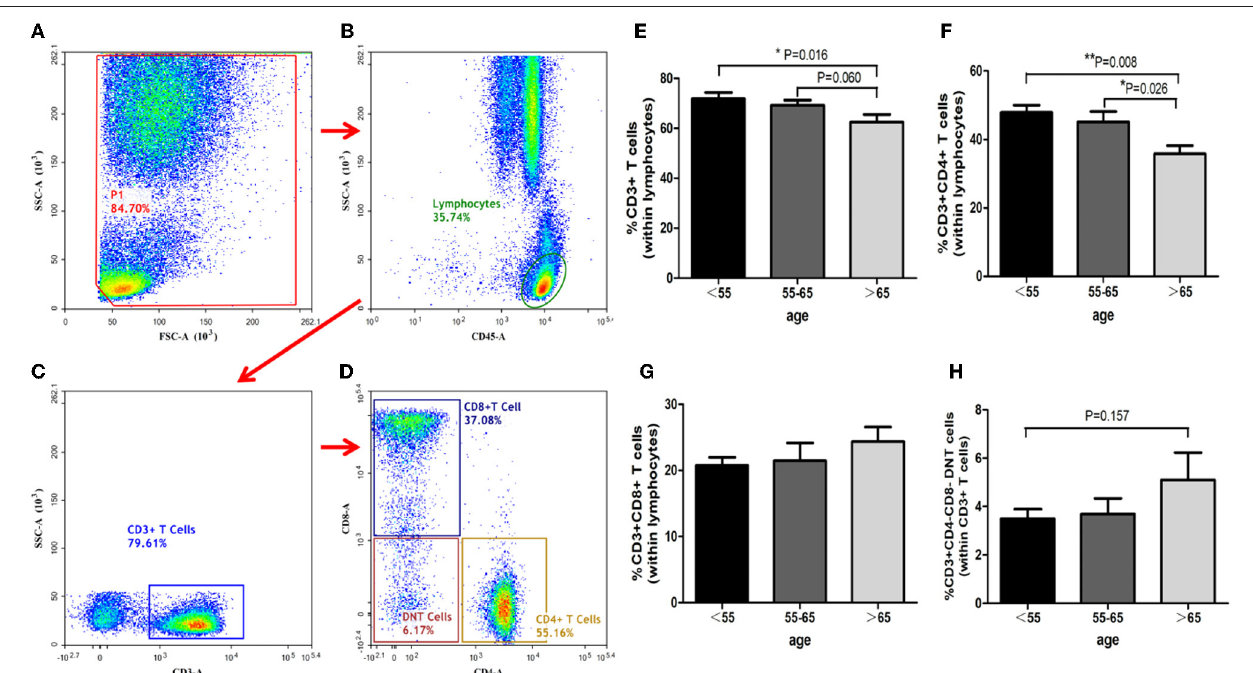
FIGURE 4 | Identification of T-cells and analysis of its subsets. T cells identification with the gating strategy. (A) : P1. (B) : Lymphocytes. (C) : CD3 + T-Cells. (D) : CD4 + T-Cells; CD8 + T-Cells; DNT Cells. Percentages of T-Cells among the 3 groups. (E) : CD3 + T-Cells. (F) : CD3 + CD4 + T-Cells. (G) : CD3 + CD8 + T-Cells. (H) : CD3 + CD4 − CD8 − T